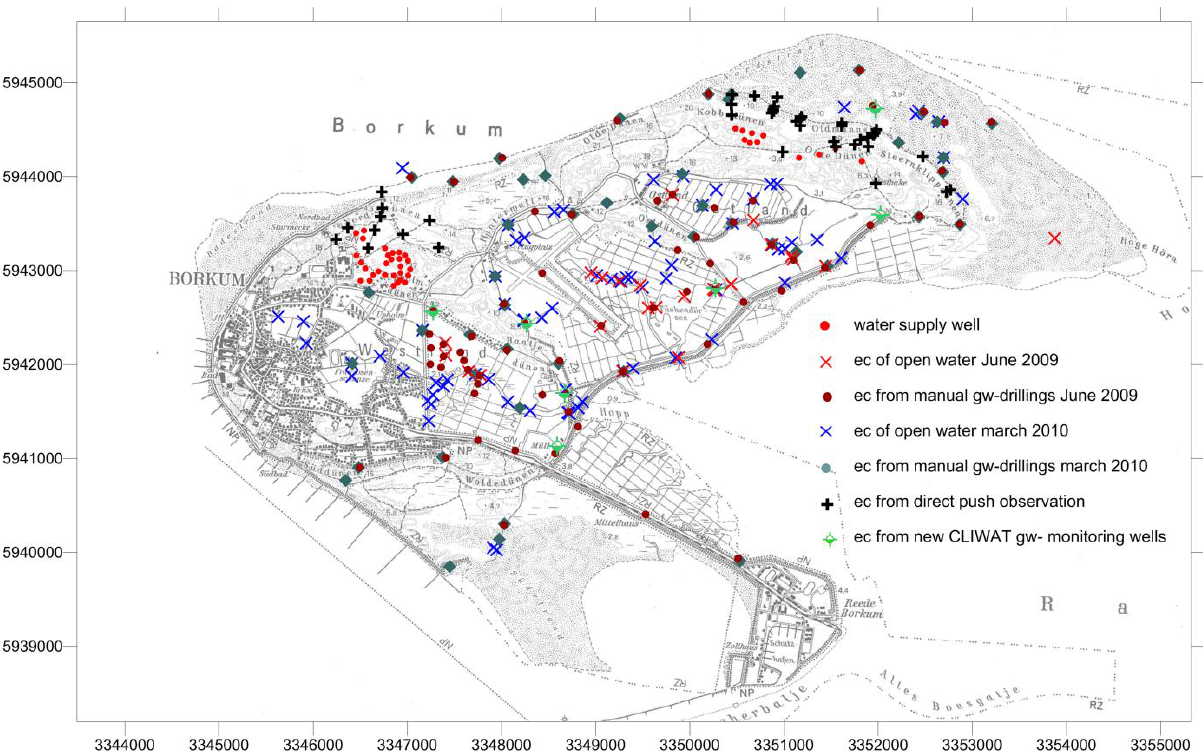
Fig. 4. Observation points of electrical water conductivity (ec) and temperature at the surface of the groundwater table during June 2009 and March 2010, all 260 locations are represented.